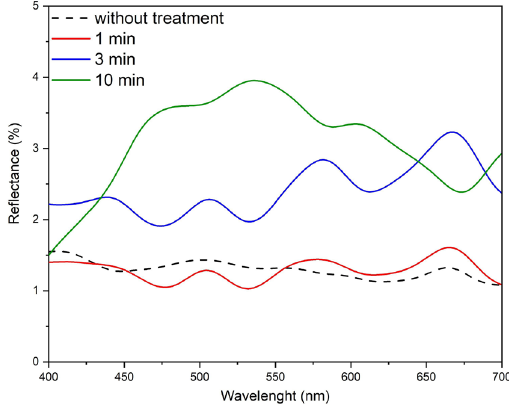
Figure 10. Optical reflectance of buckypapers as a function of wavelength in the range of visible light (400 to 700